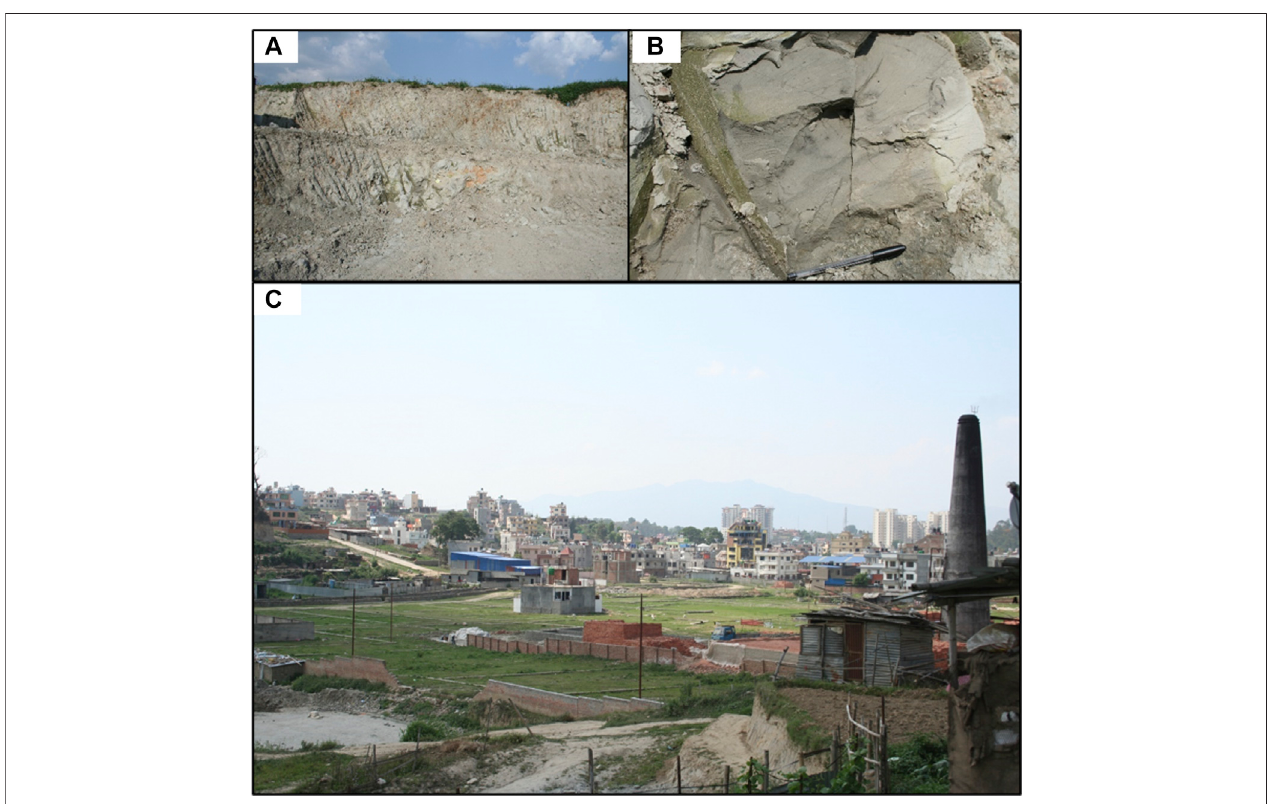
FIGURE 2 | (A) Cut faces at site 01, brickworks (B) material in cut faces at site 01, surfaces are baked but show light-grey silty material (C) Harisiddhi site area, looking northwest from SCPT10A [Photos: C. E. L. Gilder].